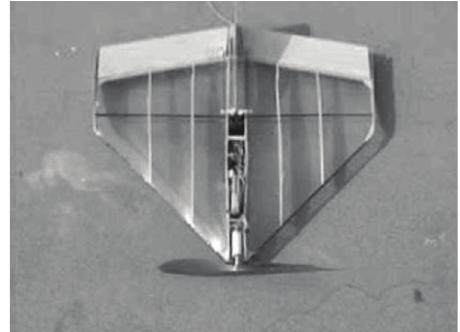
Figure 9: TH360 prototype MAV [16].